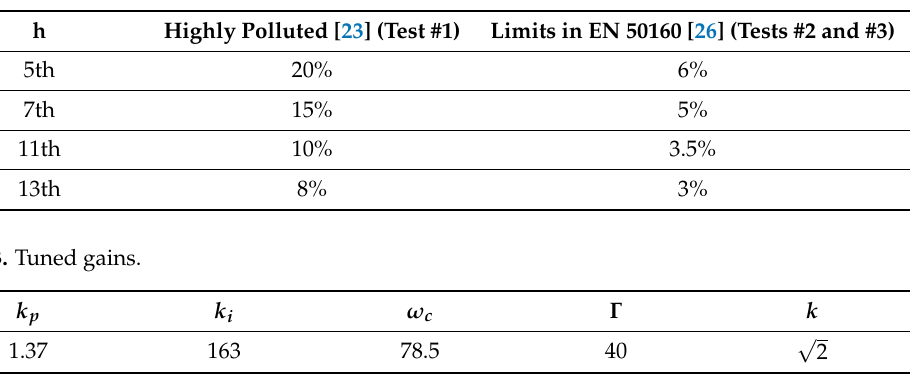
Table 2. Harmonics magnitude (% V + ).